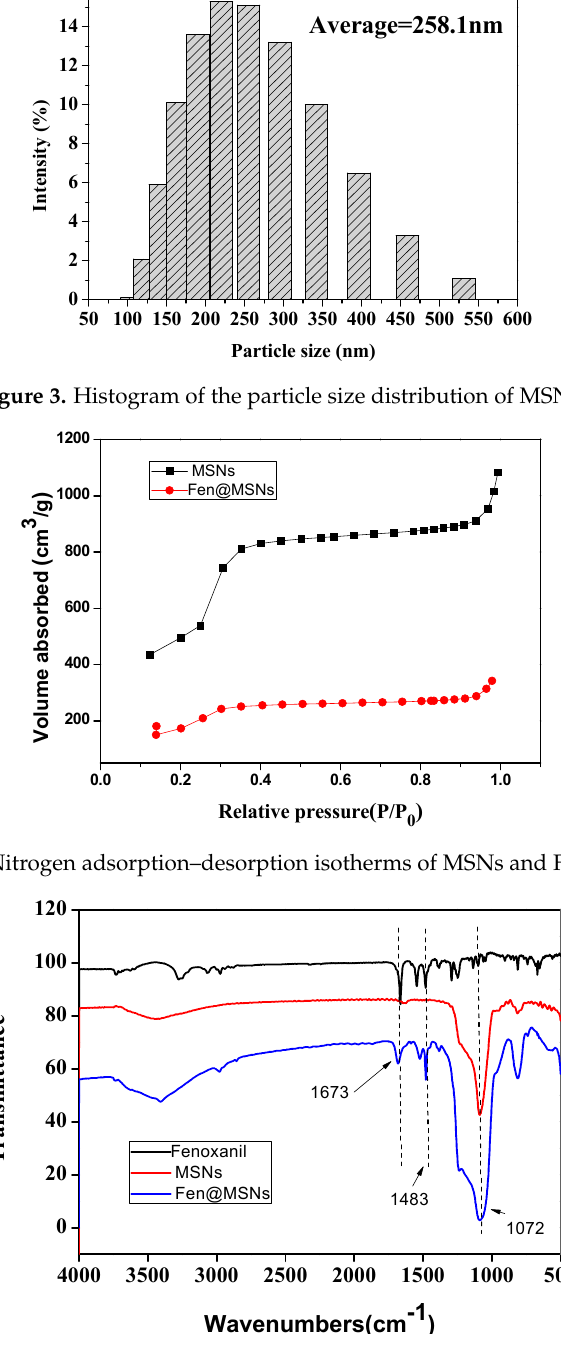
Figure 5. Fourier transform infrared (FTIR) spectra of Fenoxanil, MSNs, and Fen@MSNs.